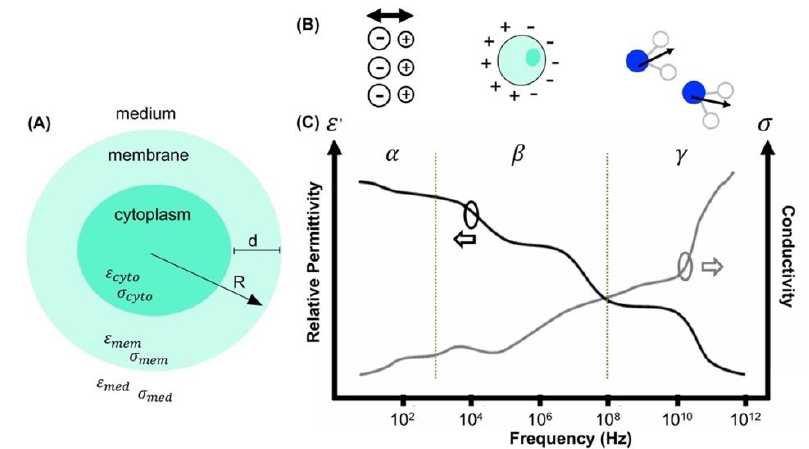
Figure 3. ( A ) Schematic of single shell spherical model for cells [37], ( B ) ionic, interfacial, and dipolar polarization mechanisms [38] associated with ( C )  ,  , and  dielectric dispersions [38,39],